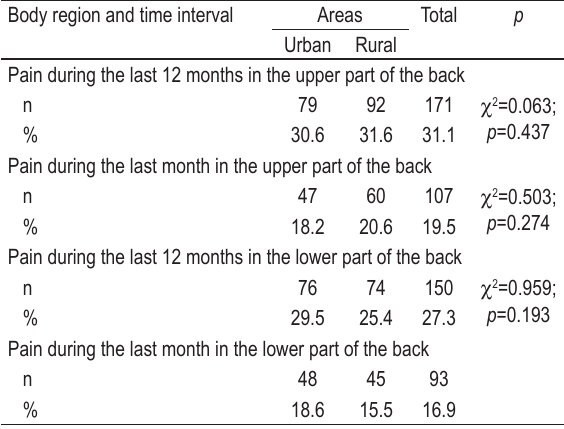
TABLE 4. The review of respondents with pain in the upper part of the back and the lower back Body region and time interval Areas Total p